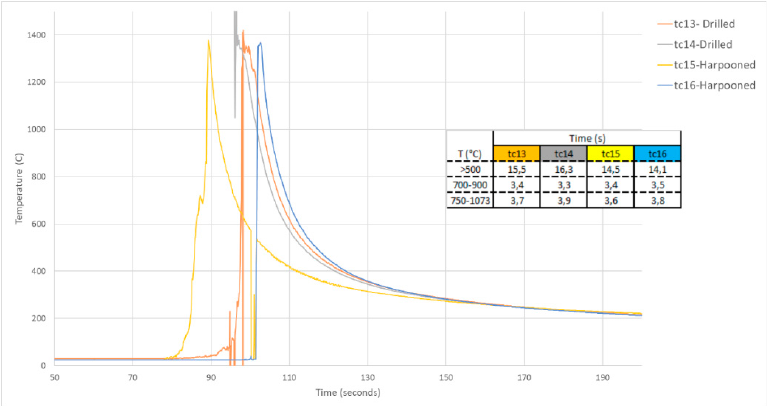
Figure 5. Temperature vs. time plots in Weld Pass 7 in the GR weld registered by using two thermocouples harpooned in the weld metal and two thermocouples inserted into drilled holes. The table embedded in the plot shows the time at which the deposited weld metal was exposed at the three ranges of temperatures studied.